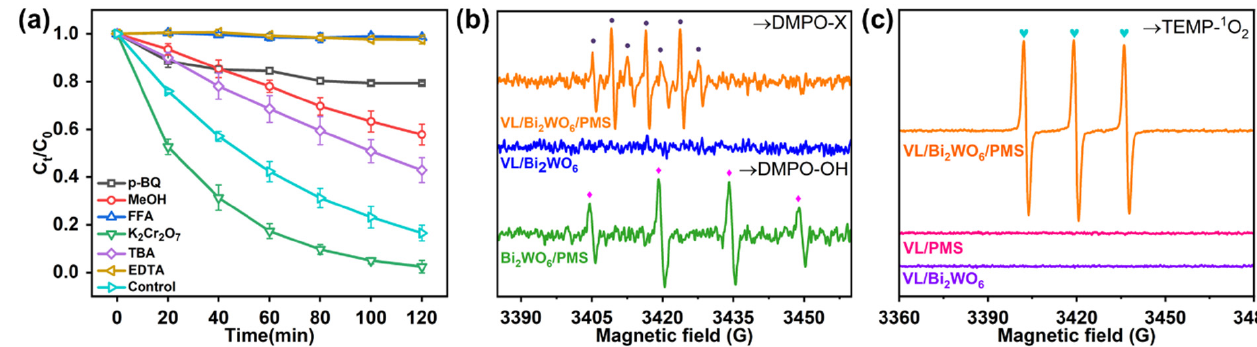
Figure 3. The quenching experiments of the VL/Bi 2 WO 6 /PMS process for CBZ degradation ( a ), EPR spectra by DMPO in water ( b ), EPR spectra by TEMP in water of the VL/Bi 2 WO 6 and VL/Bi 2 WO 6 /PMS ( c ). Experimental conditions: LI = 200 mW cm − 2 , Bi 2 WO 6 dosage = 1.0 g L − 1 , [PMS] 0 = 0.50 g L − 1 , [CBZ] = 10 mg L − 1 , pH = 7.0, T = 25 °C. p-BQ = 10 mM, MeOH = 200 mM, FFA = 20 mM, K 2 Cr 2 O 7 = 10 mM, TBA = 200 mM, EDTA = 10 mM.